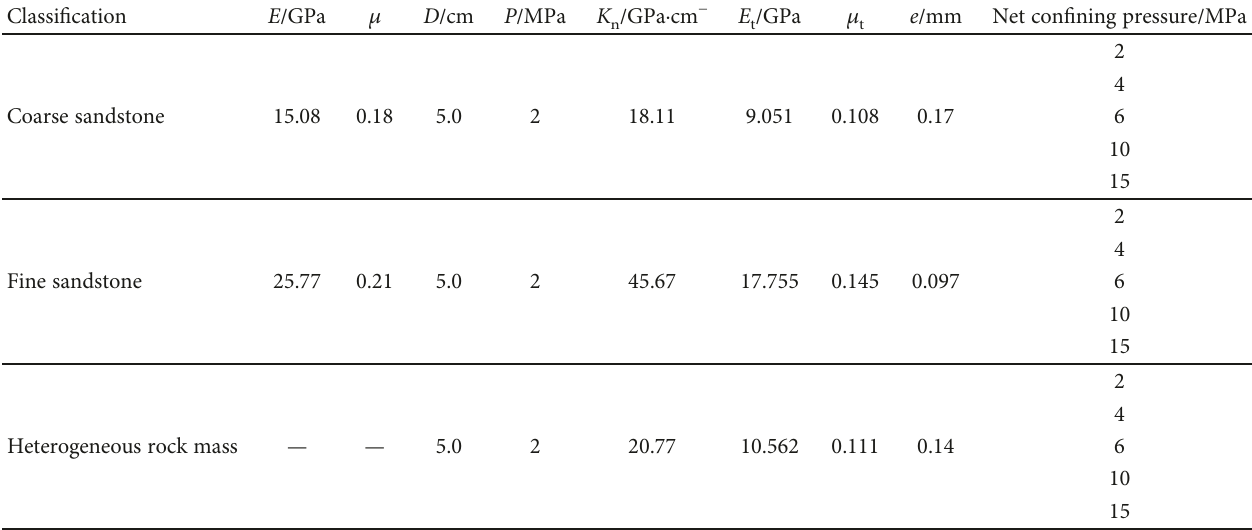
Table 2: Calculation of various parameters and permeability coe ffi cient of fractured rock